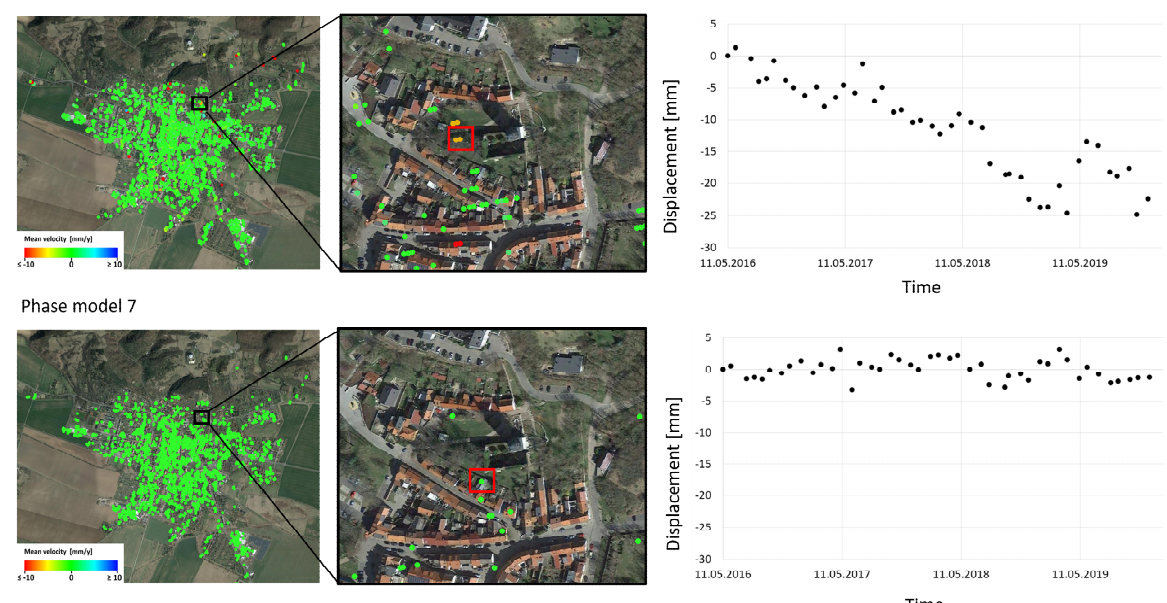
Figure 4bis: Time-Series displacements at the location of the Church Tower with different phase models; left: velocity map for the city of Bad Frankenhausen; middle: zoom-in to the church location; right: displacement profiles